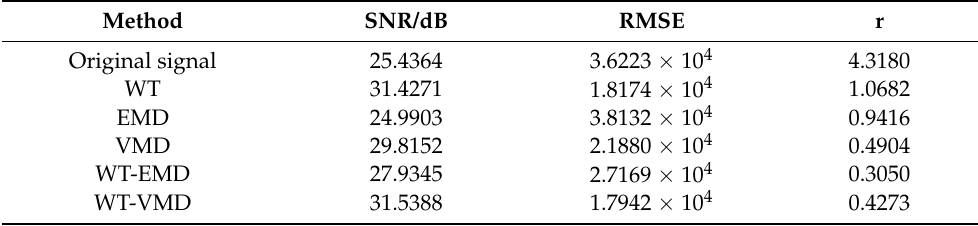
Table 6. Evaluation index of 1000-pulse cumulative signal (with aerosol and clouds) after